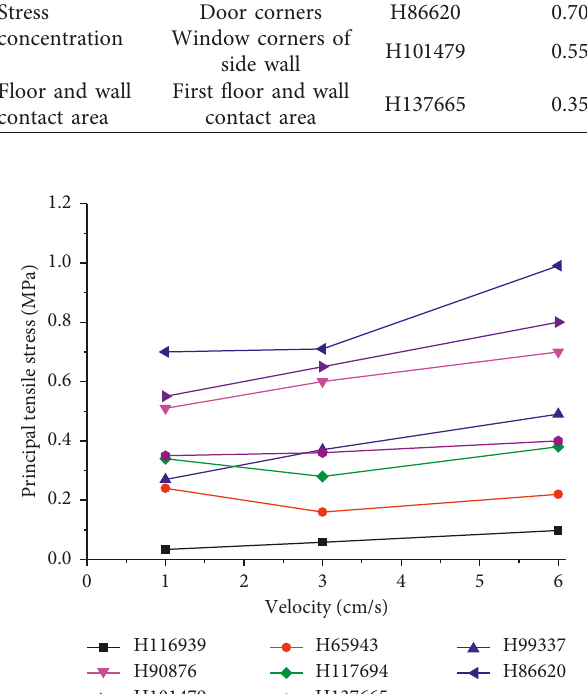
Figure 25: The PTS curve of local members under different peak particle velocities.